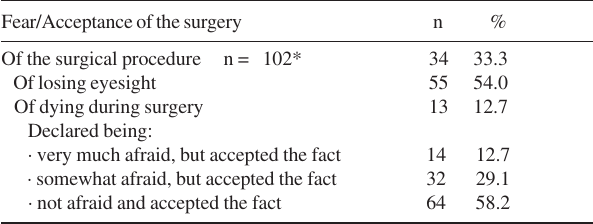
Table 2 - Fear and acceptance of cataract surgery (N=110)